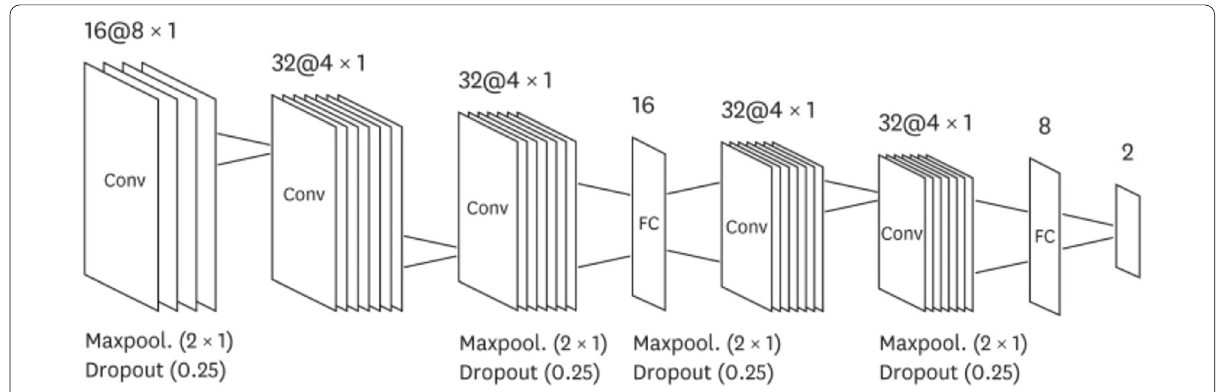
Fig. 2 Seven-layered optimal architecture of the CNN model predicting risk of atrial fibrillation